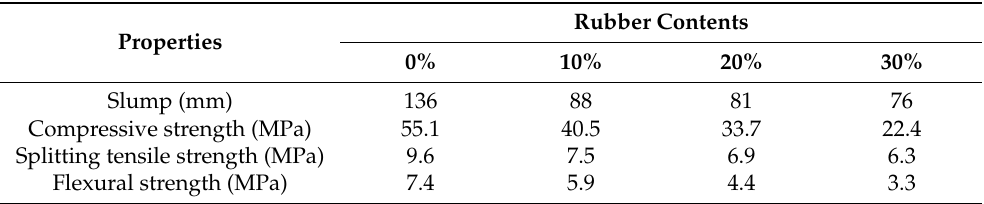
Table 5. Results of the concrete mixture incorporating R1 rubber.